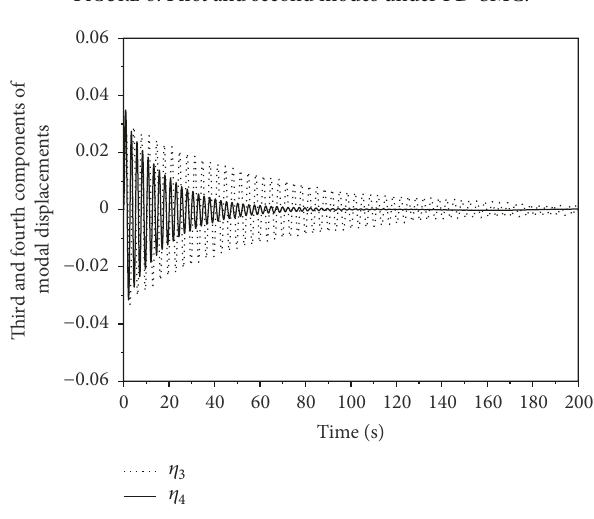
Figure 7: Third and fourth modes under PD-SMC.